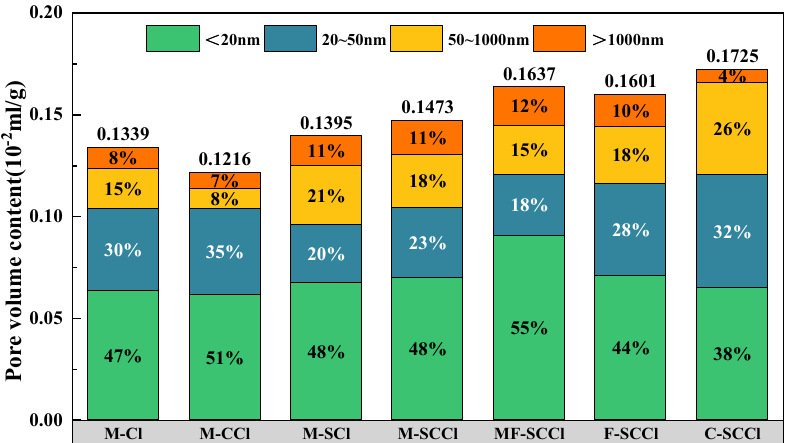
Figure 9. Influence of different erosion environments on the pore structure of specimens. The fractal dimension model of concrete pore volume can be used in the Menger sponge configuration and combined with mercury intrusion data to obtain the fractal dimension of pore volume. The larger the fractal dimension of pore volume is, the lower the porosity of concrete, the increase in pore surface area, and the better pore structure are [31]. The expression for the fractal dimension solution is: